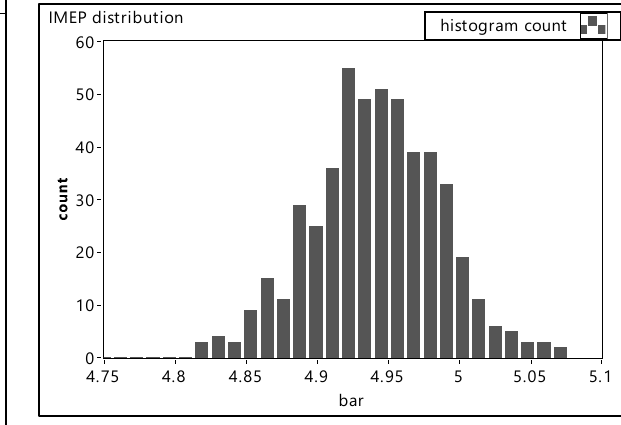
n = 3500 rpm) and Figure 10b shows the corresponding histogram of IMEP distribution (mean IMEP = 9.11 bar and SD = 0.214